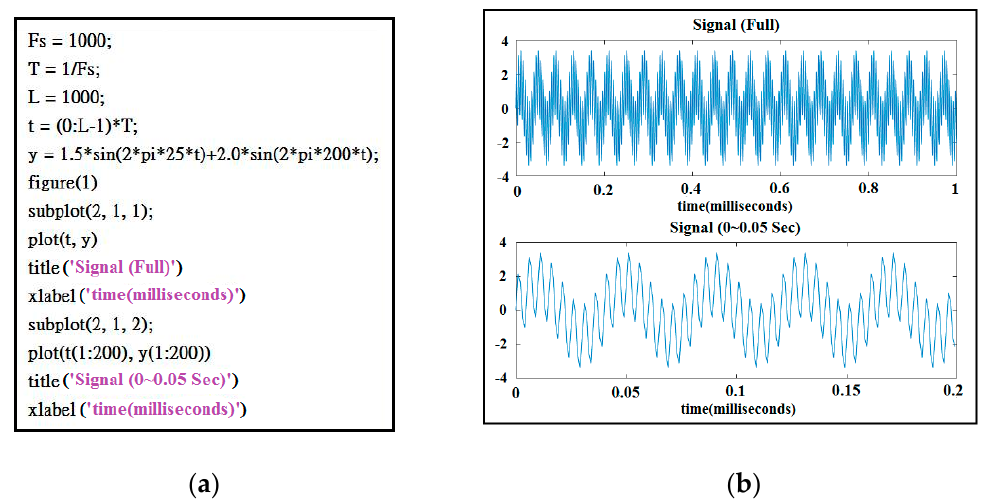
Figure 7. Structural anomaly software development testing figures: ( a ) time domain program; ( b ) time domain signal graphs.